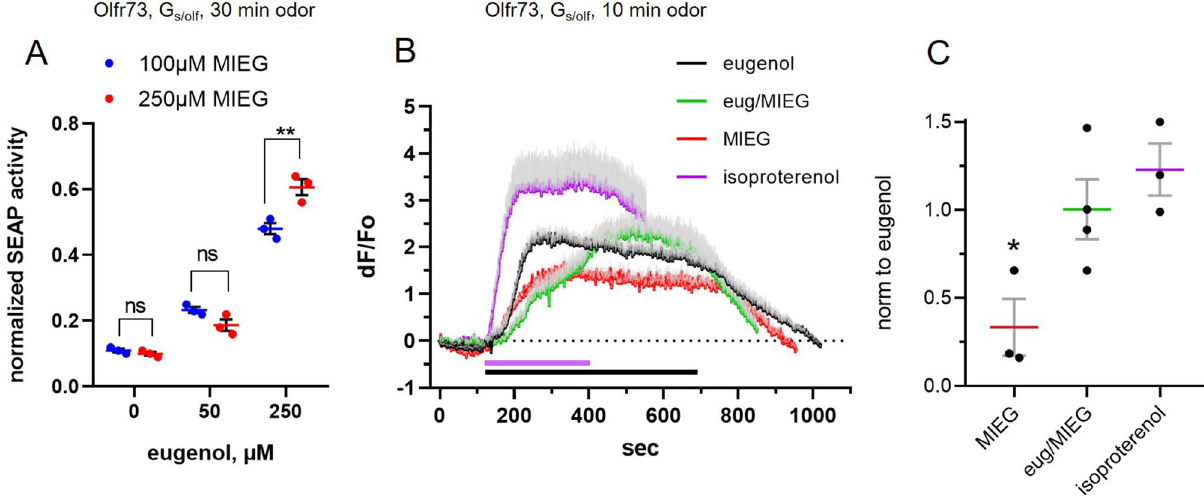
Figure 6. Prolonged exposure to Olfr73 ligands activates sustained cAMP build-up and reveals absence of antagonism in a binary mix of eugenol and methylisoeugenol. ( A ) HEK293 cells co-expressing untagged Olfr73 generated cAMP following a 30-min incubation with methylisoeugenol (MIEG) alone or its mixture with eugenol. cAMP was measured indirectly by the activity of Cre-SEAP (multiple t-test, p = 0.288 (0 µM eugenol); p = 0.077 (50 µM eugenol); **p = 0.013 (250 µM eugenol)). ( B ) Time-resolved cAMP-dependent activity directly measured by GCaMP3 as a Ca 2+ influx in HEK293 cells co-expressing untagged Olfr73 and CNGCmut channel, a cAMP sensor. Eugenol (100 µM), MIEG (1 mM) and their binary mix were applied for 10 min at the time indicated (arrowhead). Isoproterenol (10 µM) was applied for 5 min at the end of the experiment to confirm the functionality of cells and that the response to ligands was not saturated. Traces represent average (solid line) and SEM (gray shadow) measured in the same group of 26 cells. ( C ) Ligand induced cAMP-dependent activity was measured in at least three independent experiments at the plateau of the response and normalized to that evoked by eugenol alone. Wilcoxon paired t-test, *p = 0.018 (MIEG, n = 3); p = 0.875 (eug/MIEG, n = 4). Data are shown as mean ±